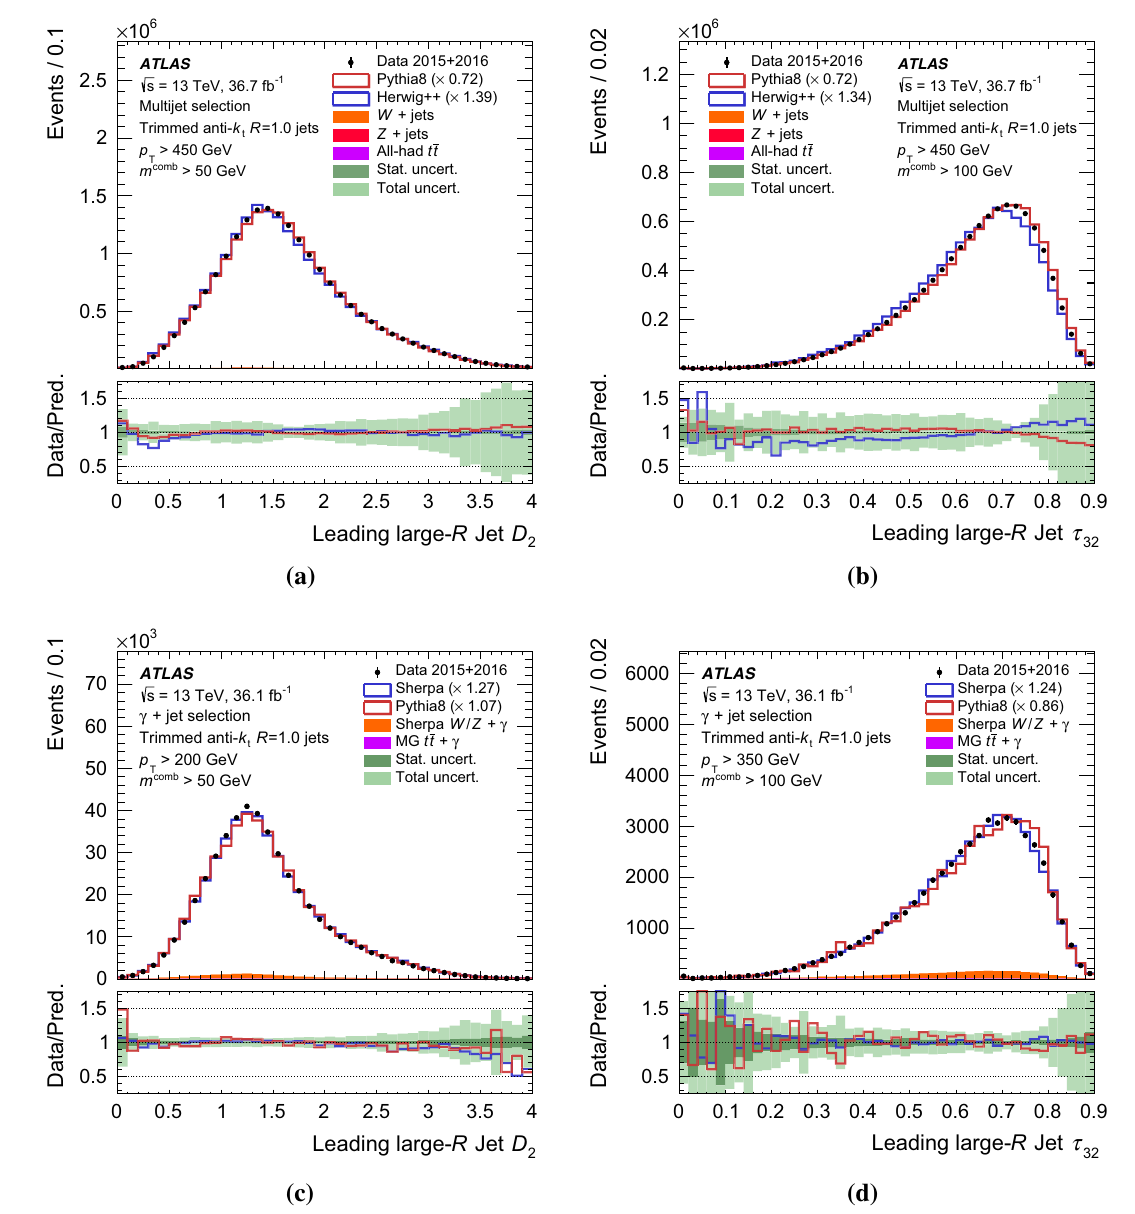
Fig. 26 A comparison of the observed data and MC predictions in the multijetand γ + jeteventsamplesfortheanti- k t R = 1.0trimmedjet D 2 ( a , c ) and τ 32 ( b , d ) spectra. The data-driven normalisation correction, described in Sect. 6.2.1, is shown in the legend beside the specific sam-